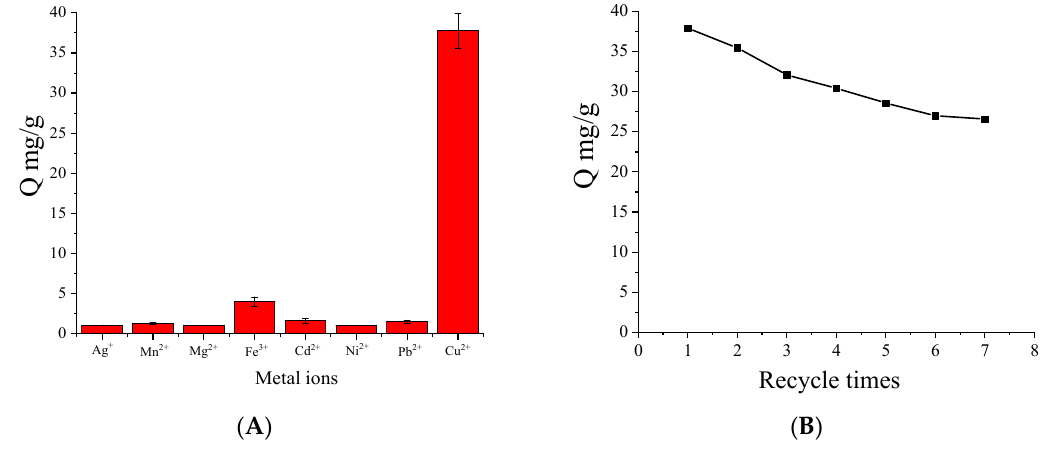
Figure 11. Adsorption of MNPs toward metal ions ( A ) and effect of regenerative times on the adsorption capacity ( B ). Adsorption conditions: V = 1.0 mL, m = 3.0 mg, C i = 10.0 mmol/L, time 2 h, temperature 15 °C, pH 7.0.